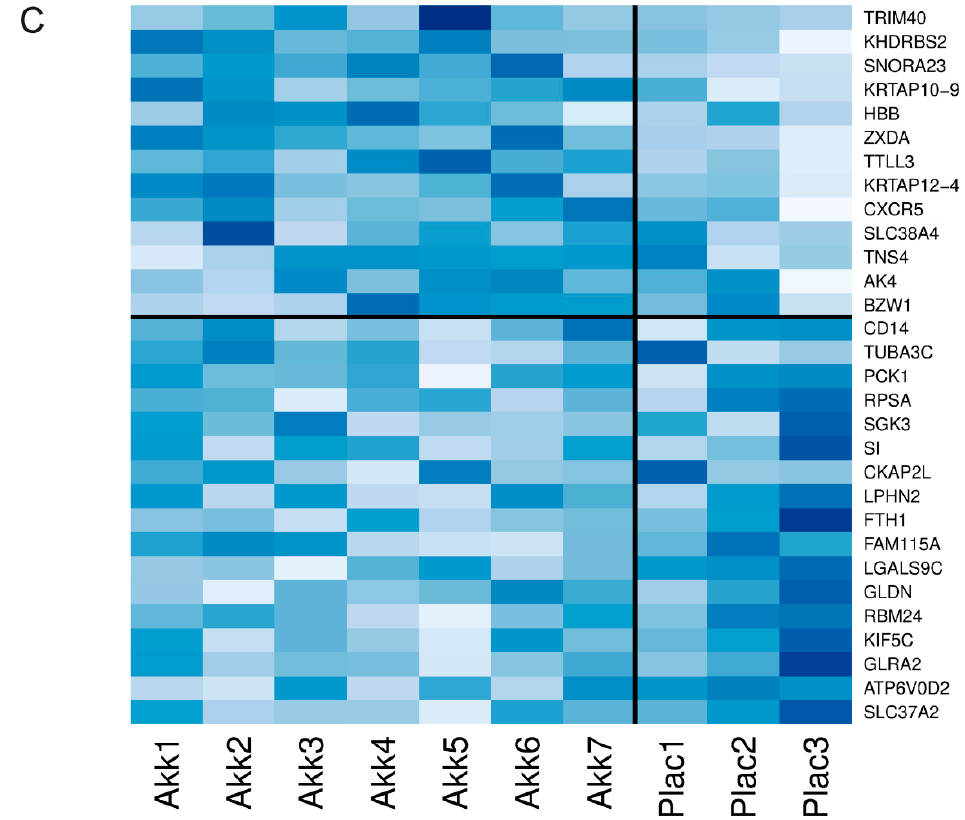
Figure 7. Proof-of-concept study in healthy humans treated 2 h with A. muciniphila on gene ex- pression versus baseline treatment and placebo . ( A ) Experimental design and volcano plot showing transcriptional analysis on colonic biopsies after 2 h perfusion versus basal. ( B ) Dark and light pink left parts of the volcano plot represent the genes downregulated 2 h after exposure to A. muciniphila , whereas the dark and light green on the right part represent the genes upregulated 2 h after exposure to A. muciniphila . Both dark pink and dark green parts are showing genes for which the expression is changed by a magnitude of at least 2-fold after 2 h perfusion with A. muciniphila versus basal (i.e., before exposure). ( C ) The heatmap is based on the 30 genes displaying significant (adj- p values smaller than 0.05) and largest absolute fold changes in the comparison A. muciniphila (Akk) vs. placebo (Plac). In the heatmap, the genes presented above the horizontal line represent upregulation of A. muciniphila vs. placebo while the genes presented below the horizontal line represent down- regulation of A. muciniphila vs. placebo. Every single column represents one subject, i.e., exposed to A. muciniphila (left of the vertical line) or exposed to placebo (right of the vertical line). The genes changed, their levels of expression, names, and statistical changes are shown in Supplementary Table